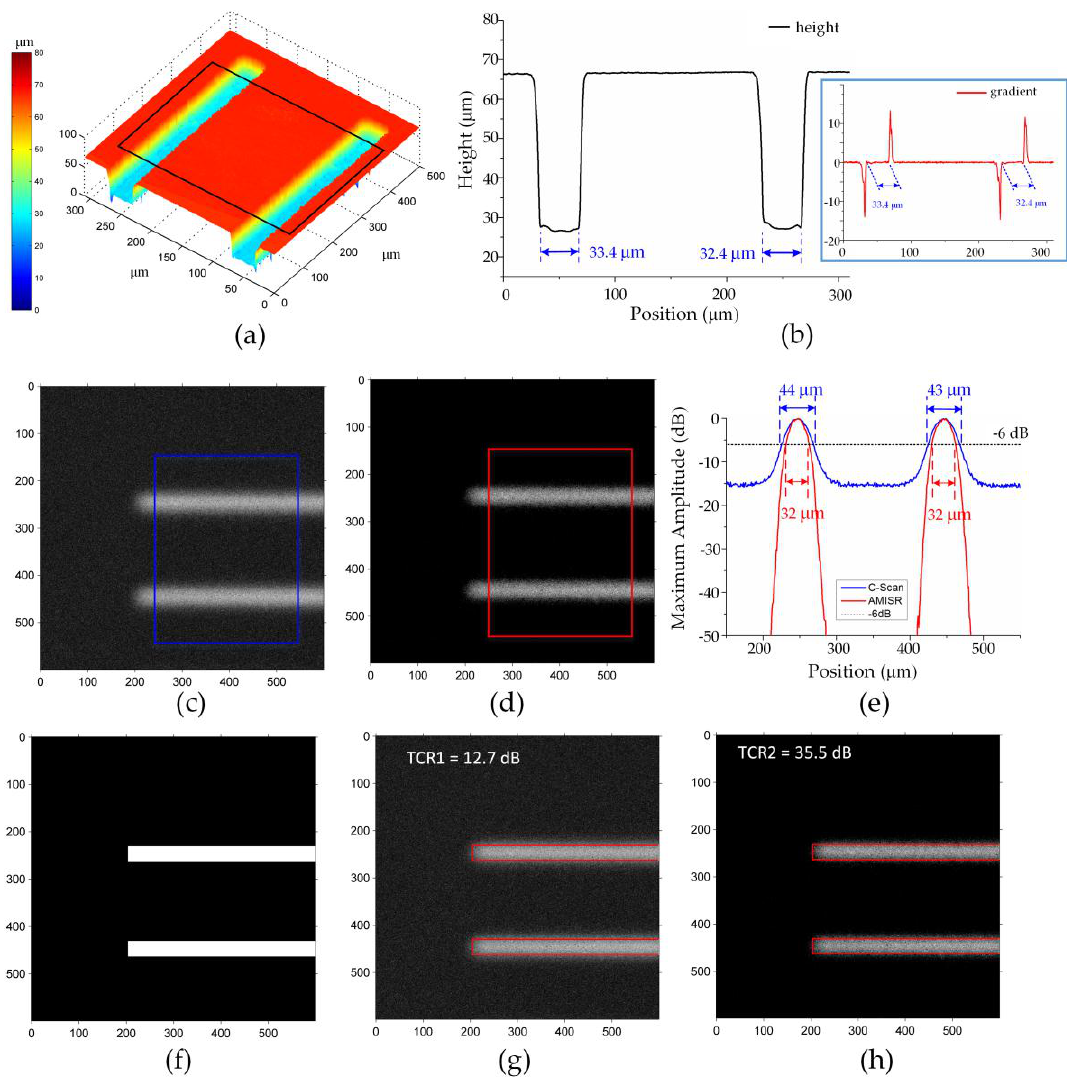
Figure 5. Results of two grooves (unit in µ m): ( a ) The topography of the grooves; ( b ) Average profile of the grooves; ( c ) Original C-scan image; ( d ) The reconstructed image formed by AMISR; ( e ) Average values of the regions indicated in (c) and (d); ( f ) The cross section of the grooves; ( g ) The original C-scan image superimposed with the mask; ( h ) The reconstructed image superimposed with the mask.